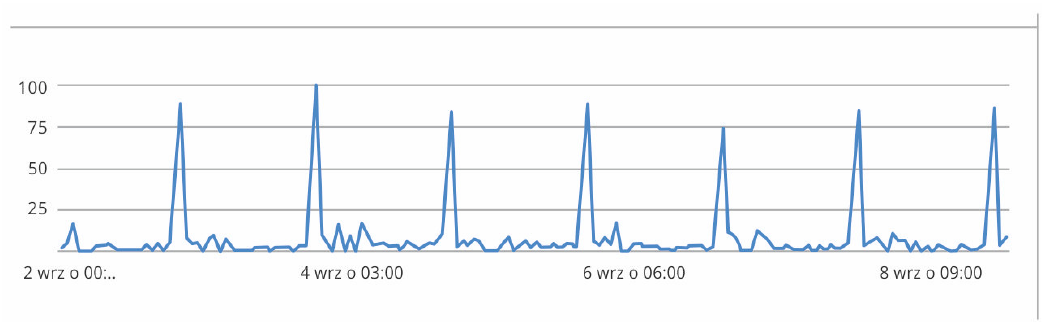
Figure 1. Keyword: “The Call of Jasna G ó ra”; Data source: Google Trends, https://www.google.com/trends (accessed on 8 September